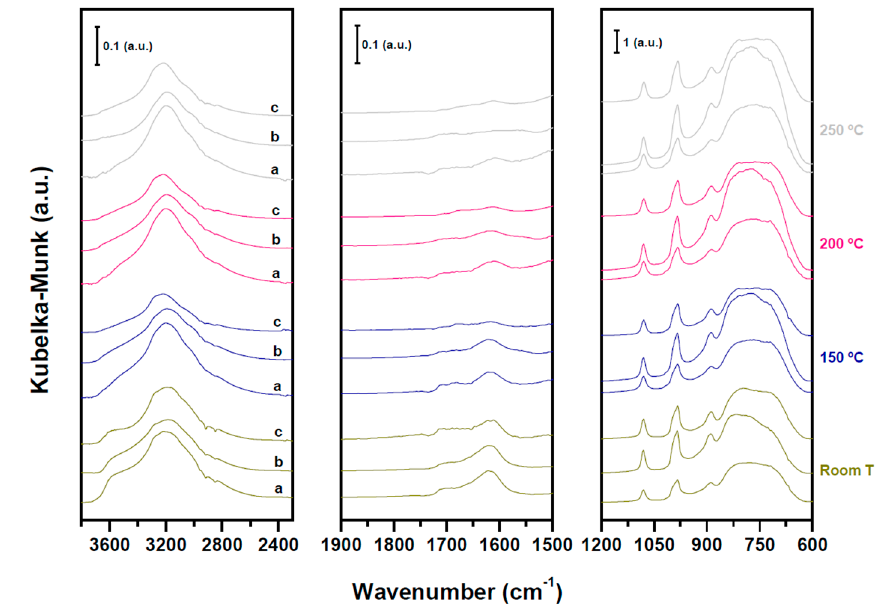
Figure 3. DRIFT spectra of xHPW/Ti acid catalysts upon heating under He flow (25–150–200 and 250 °C): 1.4HPW/Ti (a), 1.7HPW/Ti (b) and 2.7HPW/Ti (c).